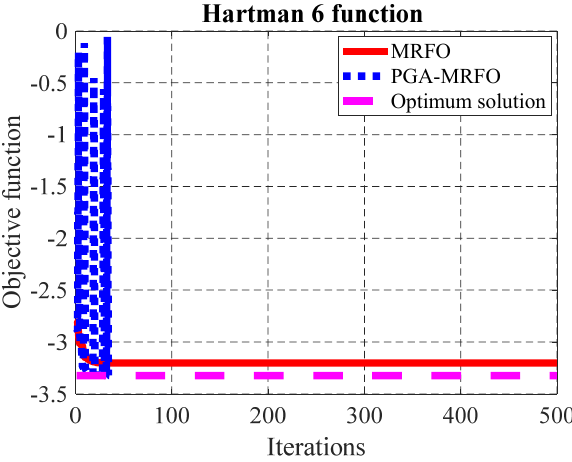
Figure 8. Converges curves for F 20 .